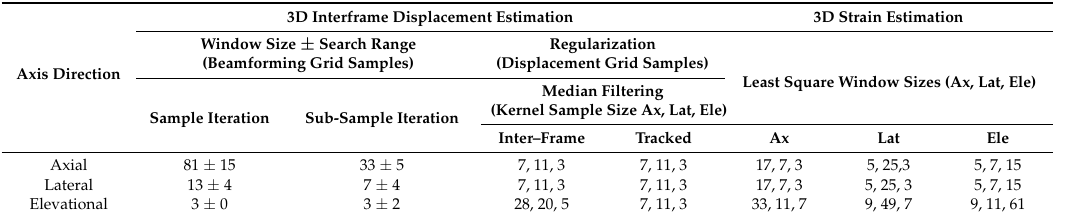
Table 2. 2-step cross-correlation-based displacement and strain estimation settings.